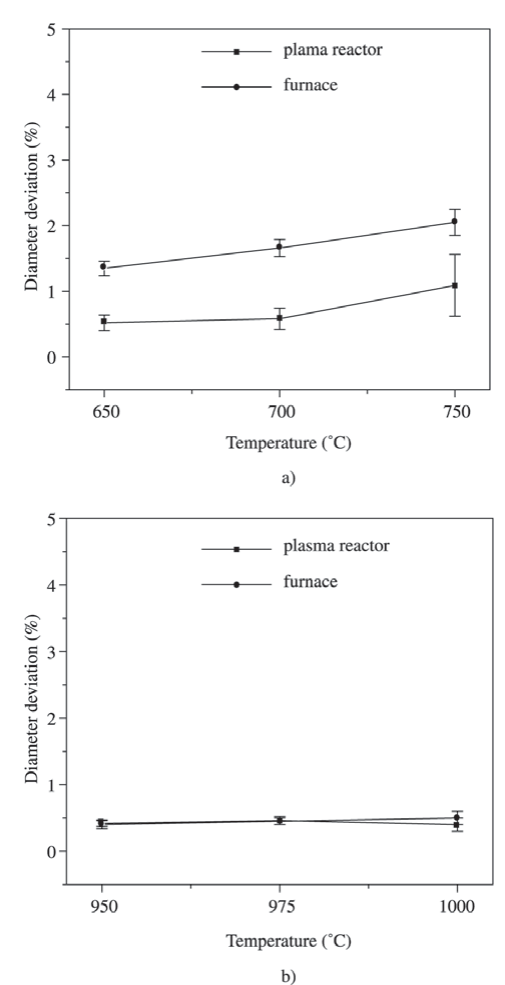
Figure 4. Diameter deviation: a) nickel samples; b) stainless steel samples.